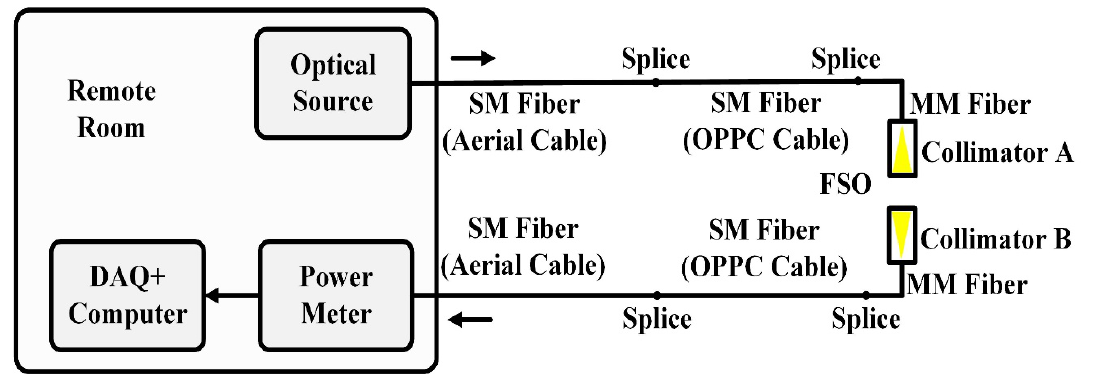
Figure 20. Block diagram of field test of the optical wireless monitoring device [77].